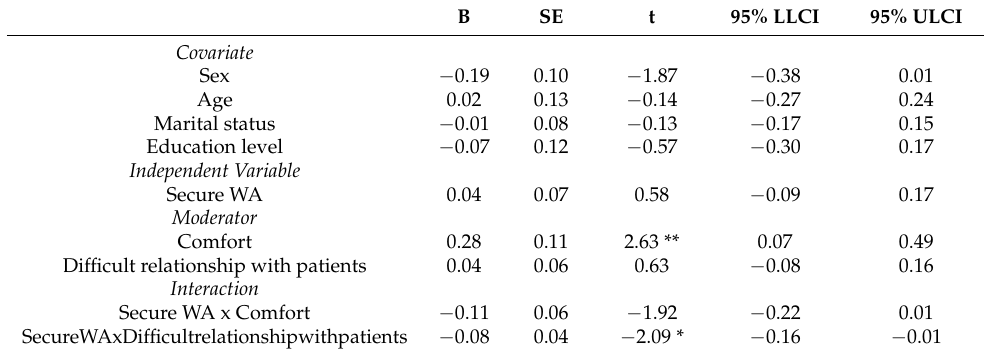
Table 5. Moderation model with secure WA as IV and Conscientiousness as